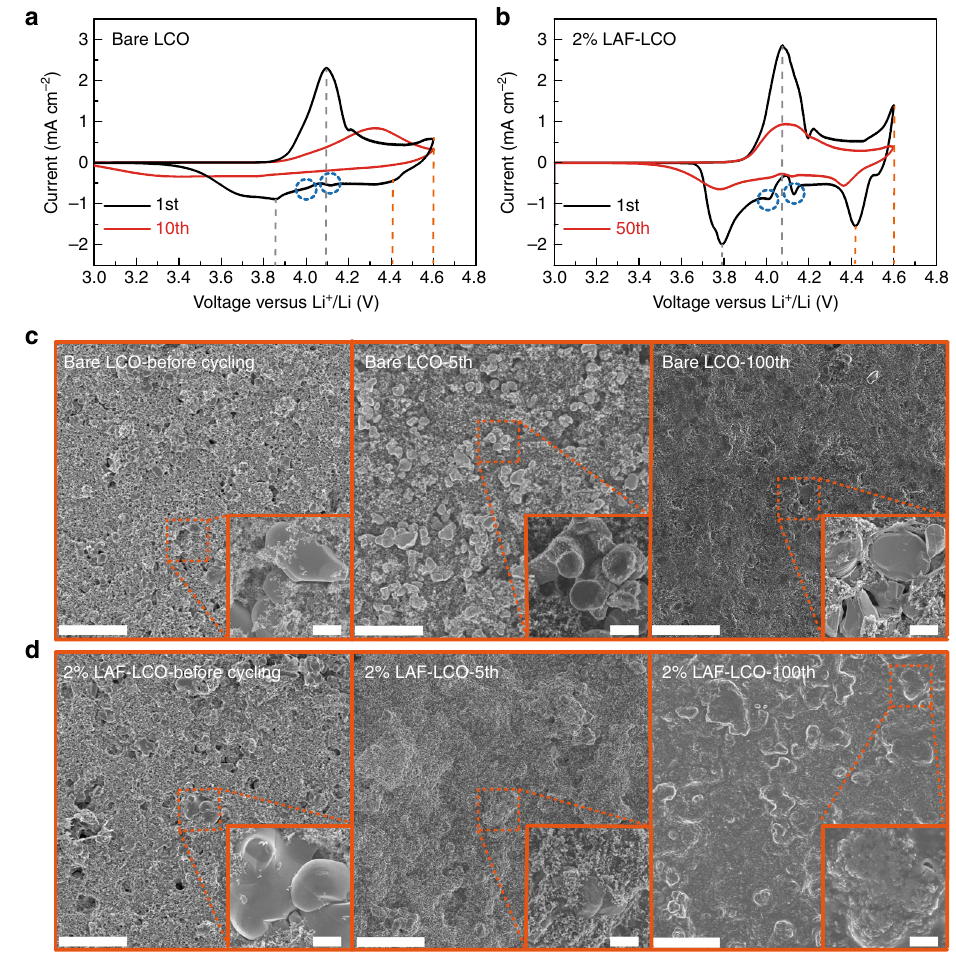
Fig. 5 Electrochemical and morphology analyses of bare LCO and 2% LAF-LCO electrodes. a , b Cyclic voltammograms of cells with bare LCO or 2% LAF- LCO electrodes at a scan rate of 0.1 mV s − 1 in the voltage range of 3.0 – 4.6 V (vs. Li + /Li). c , d Top-view SEM images of bare LCO and 2% LAF-LCO electrodes before cycling and after 5 and 100 cycles at room temperature in the voltage range of 3.0 – 4.6 V (vs. Li + /Li) at 27.4 mA g − 1 . Scale bar: 20 μ m and 2 μ m. Source data are provided as a Source Data fi